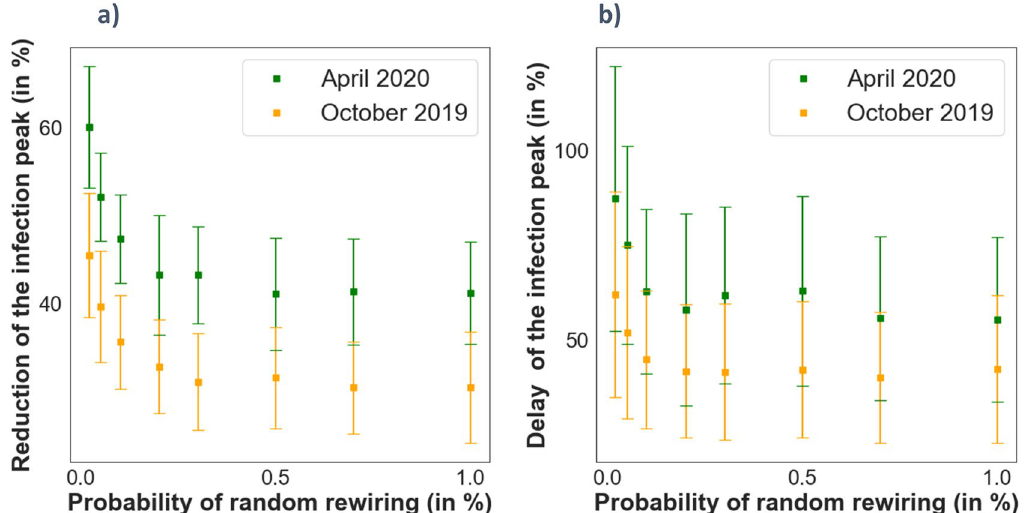
Figure 9. Peak statistics of the infection curves for different values of the rewiring probability of the Watts- Strogatz mobility model, and for both opinion scenarios October’19 and April’20. See figure S4 on the supplementary information for the time evolution of the infected individuals of some of the points shown here. − u cutoff = 0.3 ( N = 10, 000, β = 0.05, µ = 0.06,